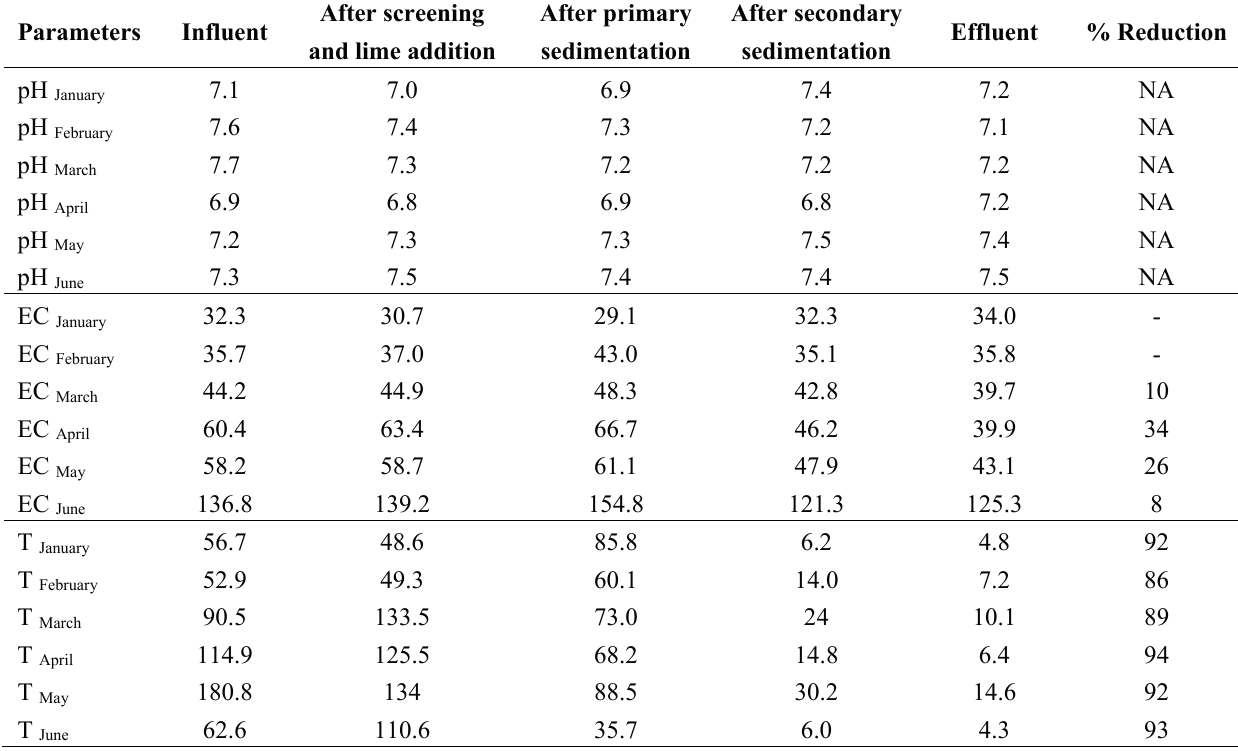
Table 1. Levels of physico-chemical parameters through the major stages of the Thohoyandou